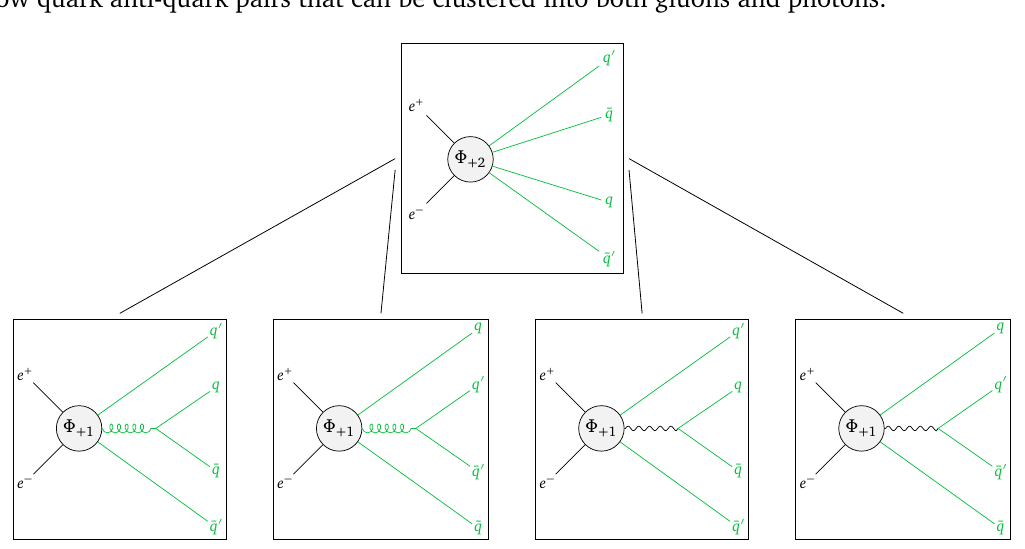
Figure 2: Histories for two quarks and to anti-quarks in the final state in fixed color QCD and QED evolution, where all carry either green or anti-green fundamental indices: Each flavour pair can either be clustered into a gluon (left two) or a photon (right two). Only one or the other assignment would be suitable in a leading color picture, depending on whether the colors match (photon) or don’t match (gluon). The exact flow is only sampled after all clustering steps are